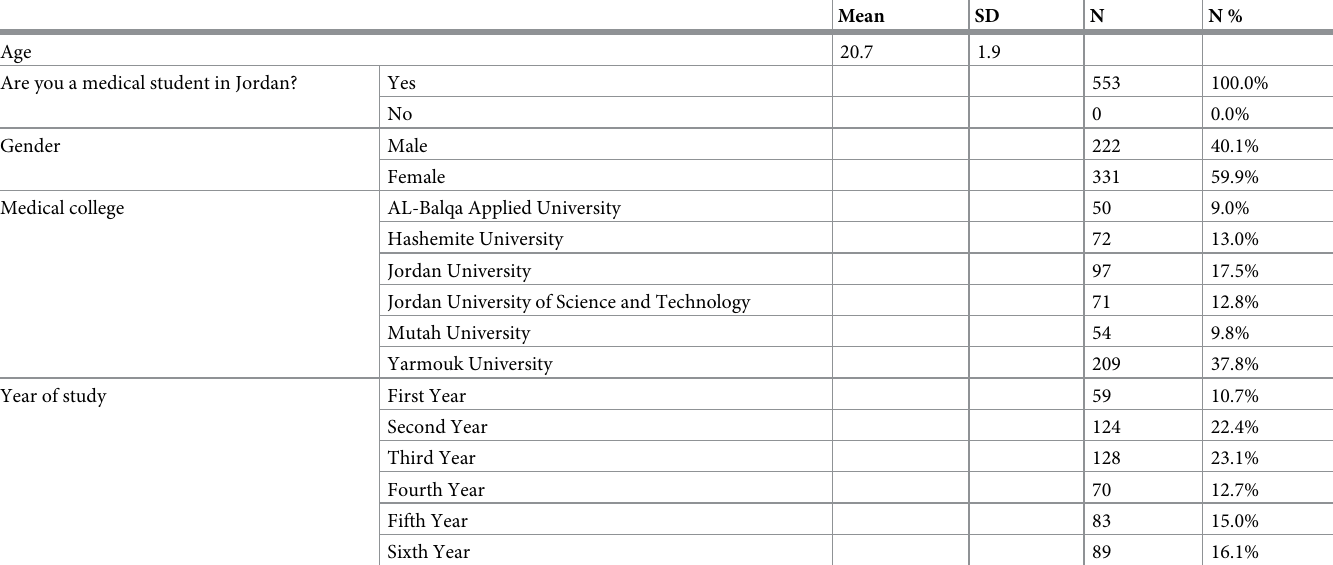
Table 1. Demographic characteristics of the study participants.